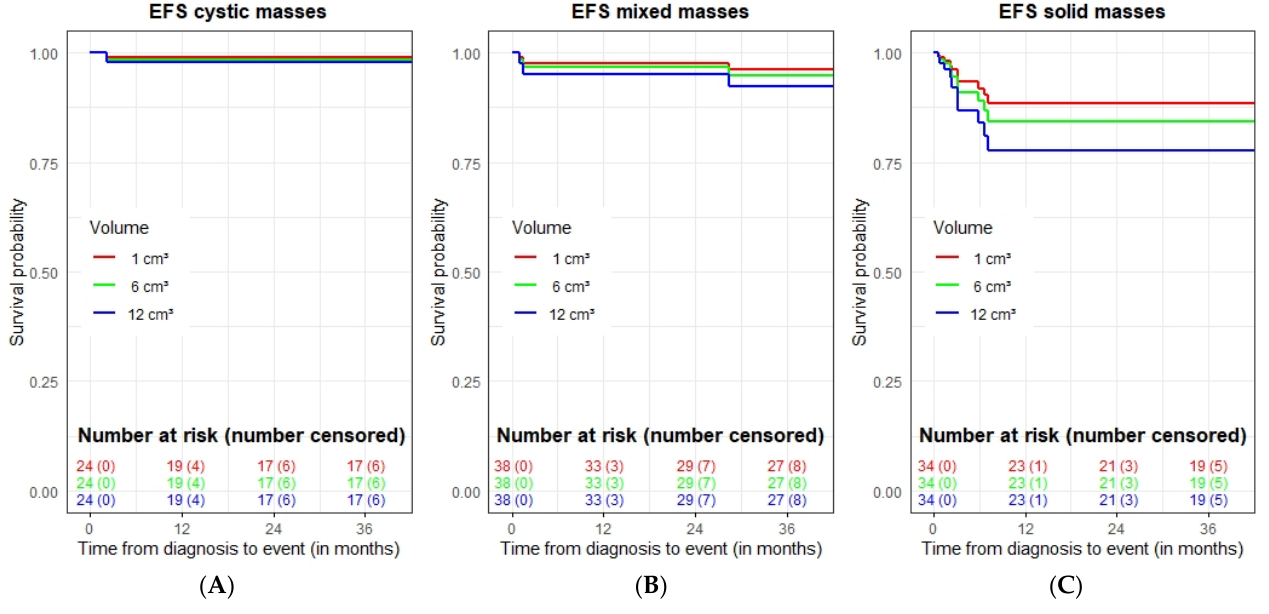
Figure 3. Event-free survival effect of volume and nature of mass for the whole cohort ( n = 96 available patients with 3D tumor measures from first postnatal US). The predictive evolution of 9 hypothetical patients is shown, combining the three types of mass structure (( A ) cystic, ( B ) mixed and ( C ) solid) with three volumes: 1 cm 3 , in red; 6 cm 3 , in green, and 12 cm 3 blue.